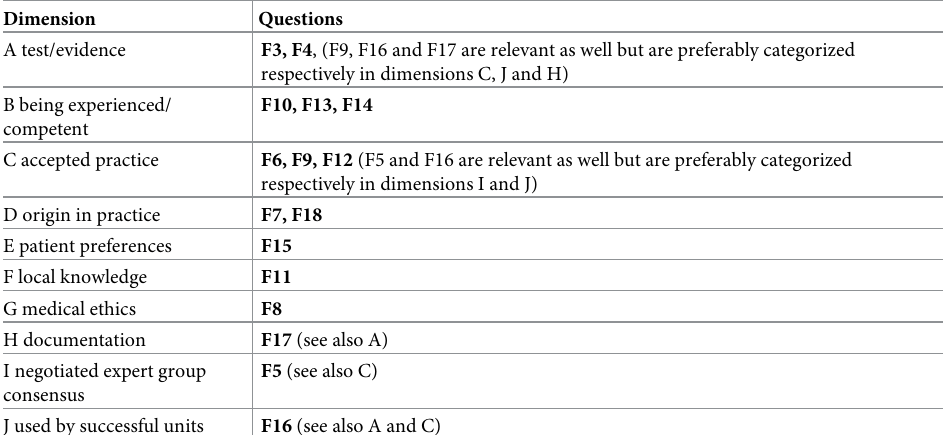
Table 4. Question prompts mapped onto prespecified (A-D) and explorative (E-J) dimensions.